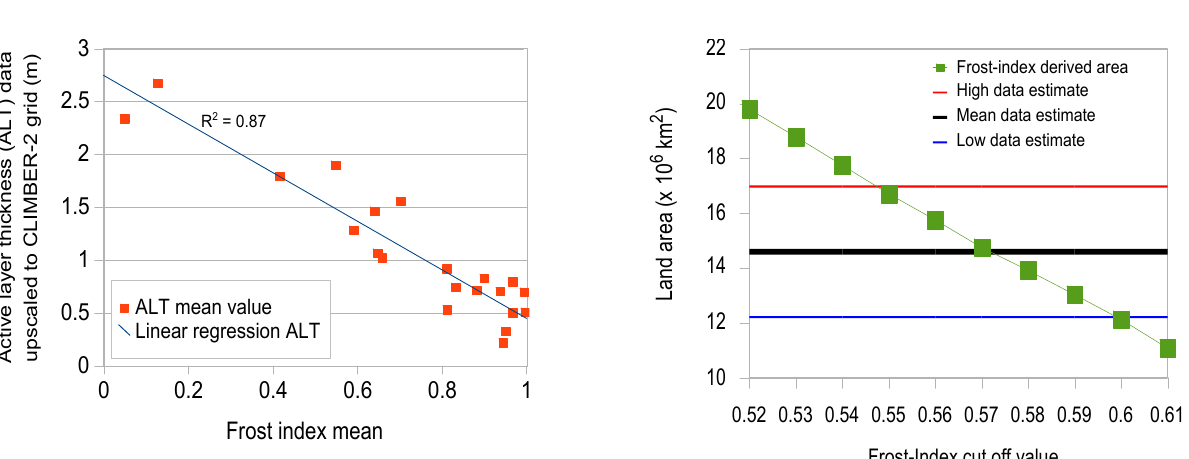
Figure 7. Measurement data for active layer thickness (CALM net- work, Brown et al., 2003) and frost index (Zhang, 1998) upscaled to the CLIMBER-2 grid scale, showing the distinct relationship of reducing active layer with increasing frost index at this scale. Note that permafrost fraction is calculated from frost index in our model (see Sect. 3.2).